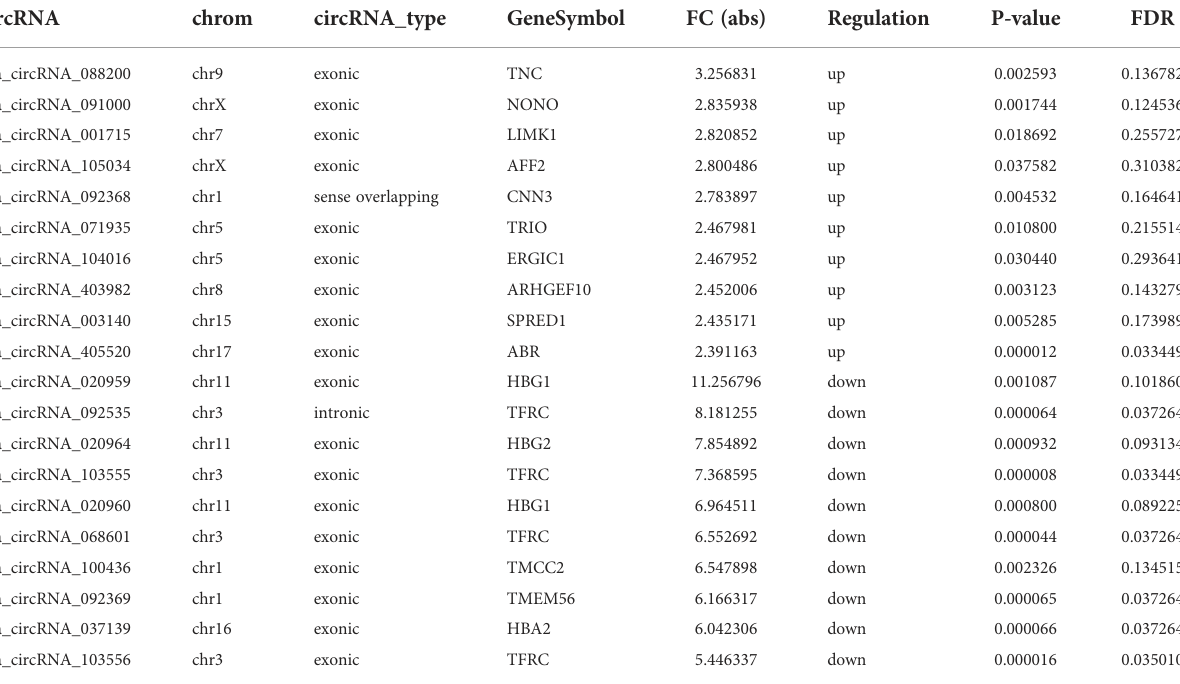
TABLE 3 Top 10 up- and down-regulated circRNAs identi fi ed by microarray analysis in peripheral blood mononuclear cells (PBMCs) of infants with retinopathy of prematurity (ROP) compared with premature controls. circRNA